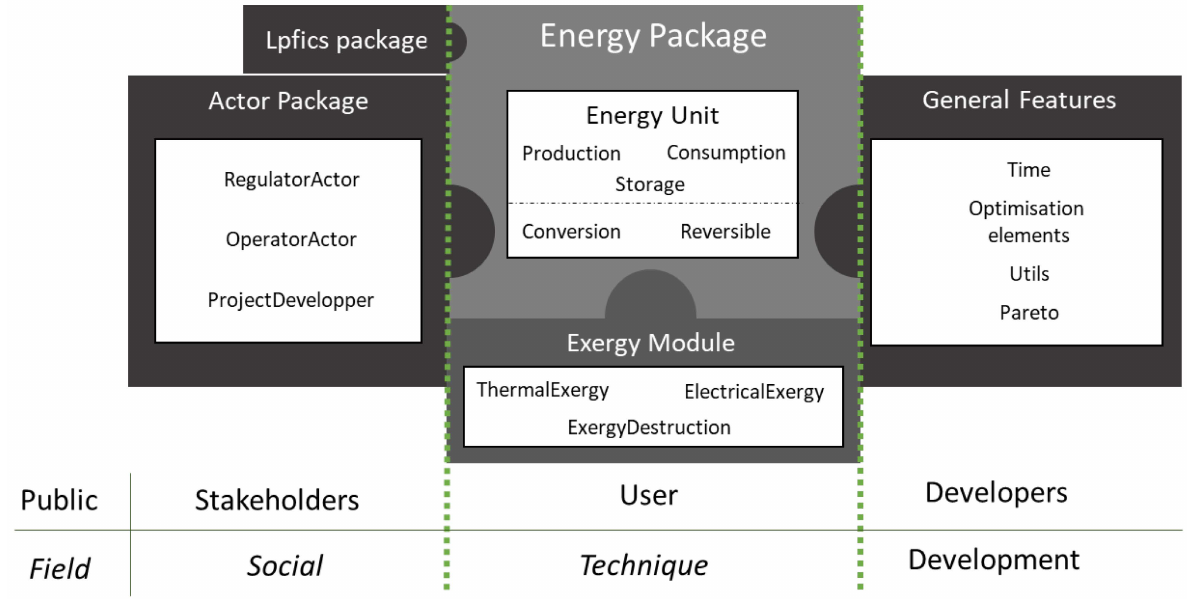
Figure 4. OMEGAlpes principle diagram including public and field. Source: